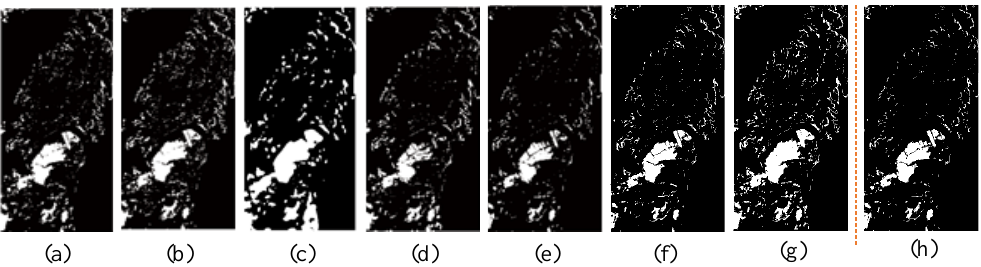
Figure 8. The change detection maps of different methods for the dataset of Poyang lake: ( a ) the change detection map of CVA; ( b ) PCA-CVA; ( c ) IR-MAD; ( d ) SVM; ( e ) CNN; ( f ) GETNET; ( g ) our method; and ( h ) ground-truth map.